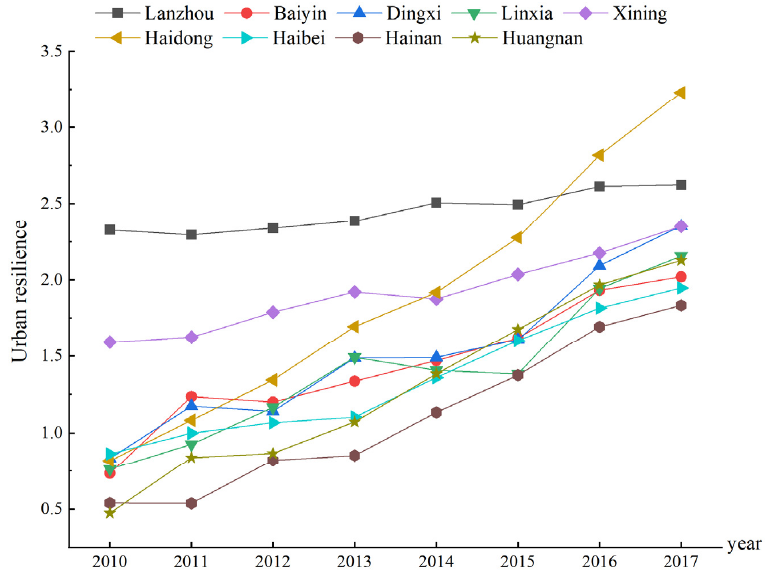
Figure 5. Trends in urban resilience of the nine cities from 2010 to 2017.